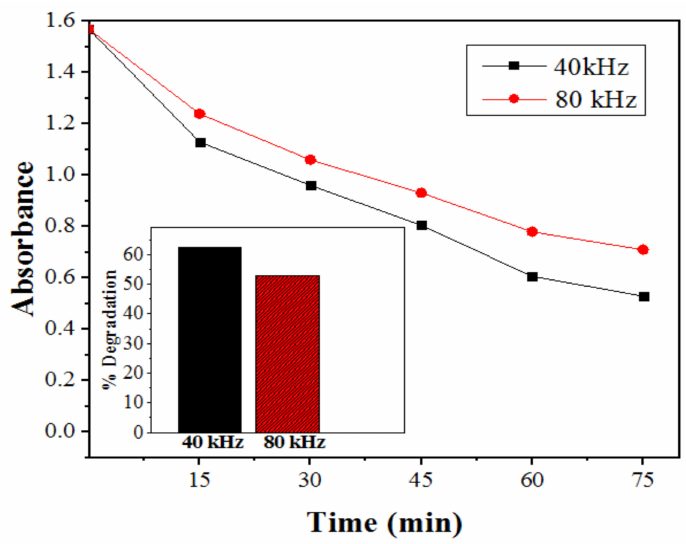
Figure 9. Effect of ultrasound frequency on degradation of SDB at optimum conditions (15 mL of 70 ppm SDB, pH 6, 75 min irradiation, 40 mg